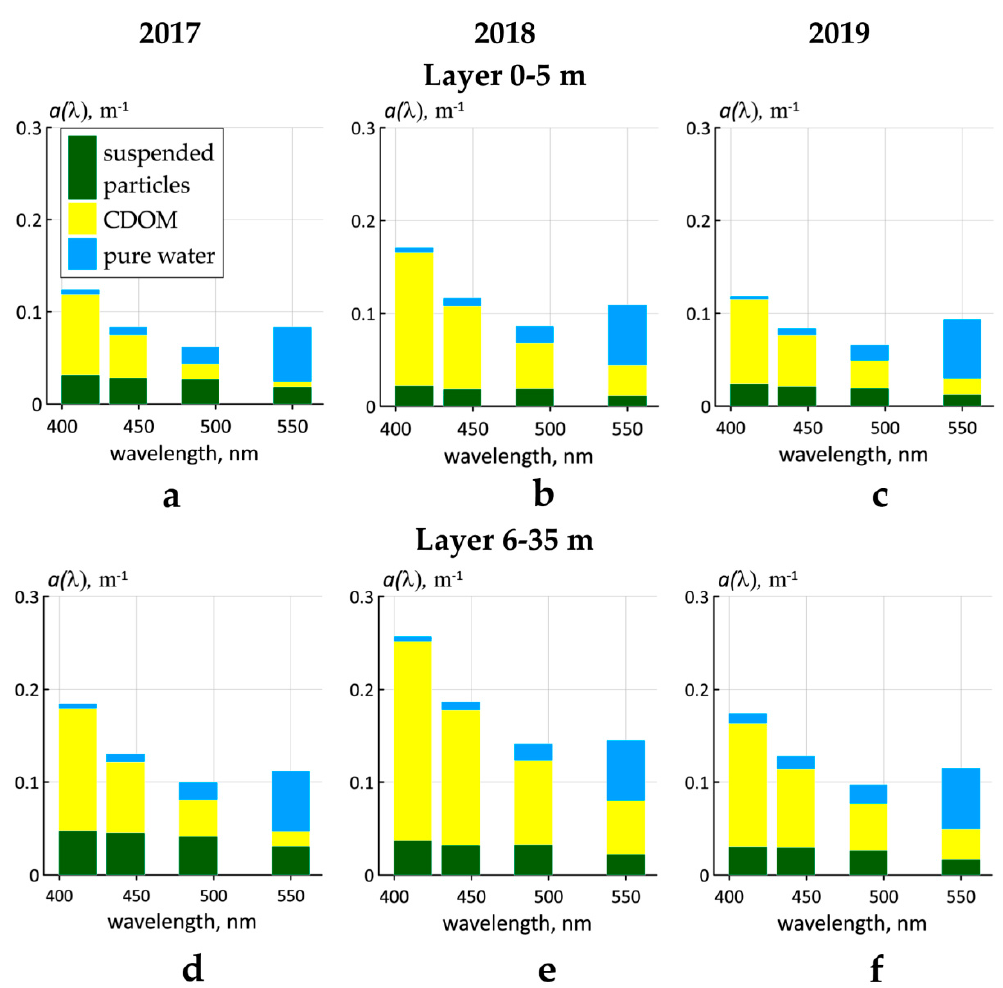
Figure 7. Contributions from the suspended matter, colored dissolved organic matter (CDOM), and pure water in the total seawater light absorption: ( a – c ) the layer from 0–5 m; ( d – f ) the layer from 6–35 m. Values are shown for 2017 ( a , d ), 2018 ( b , e ), and 2019 ( c , f ).